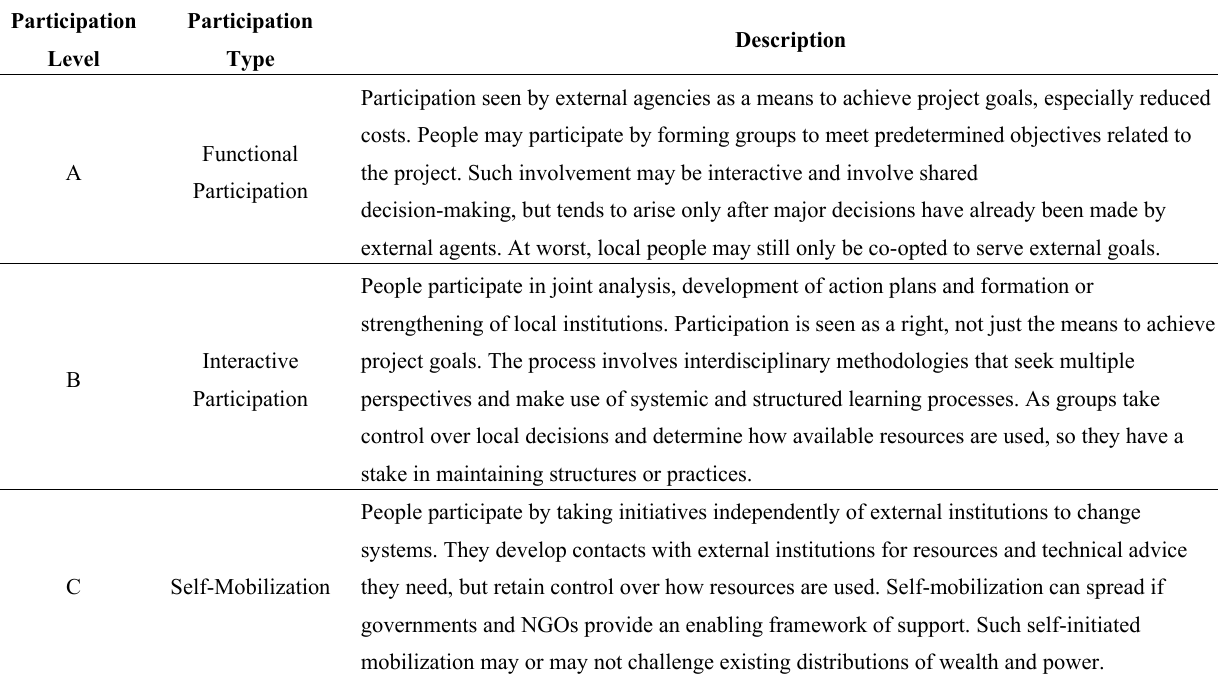
Table 2. A selection of the typology of participation: How people participate in development programs and projects (adapted from Pretty